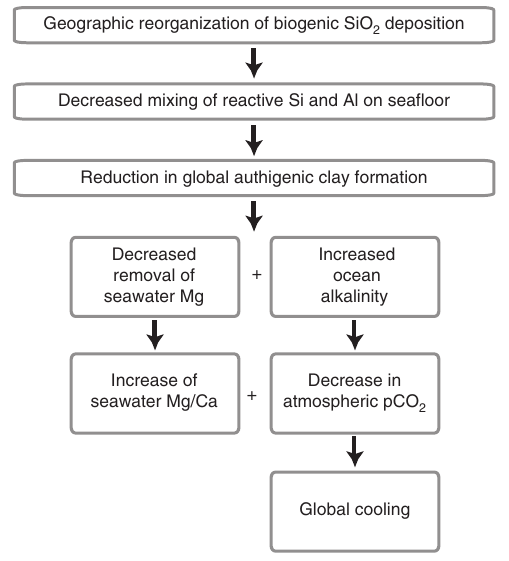
Fig. 3 Mechanism for reverse weathering affecting seawater Mg/Ca and climate. The proposed mechanism by which geographic reorganization of biogenic Si deposition and a reduction of global authigenic clay formation could cause an increase in seawater Mg/Ca and global cooling, as is observed over Cenozoic. The decreased sink of alkalinity in the ocean would be balanced by a reduction in global silicate weathering until the charge-weighted masses of sources are balanced by the sinks of